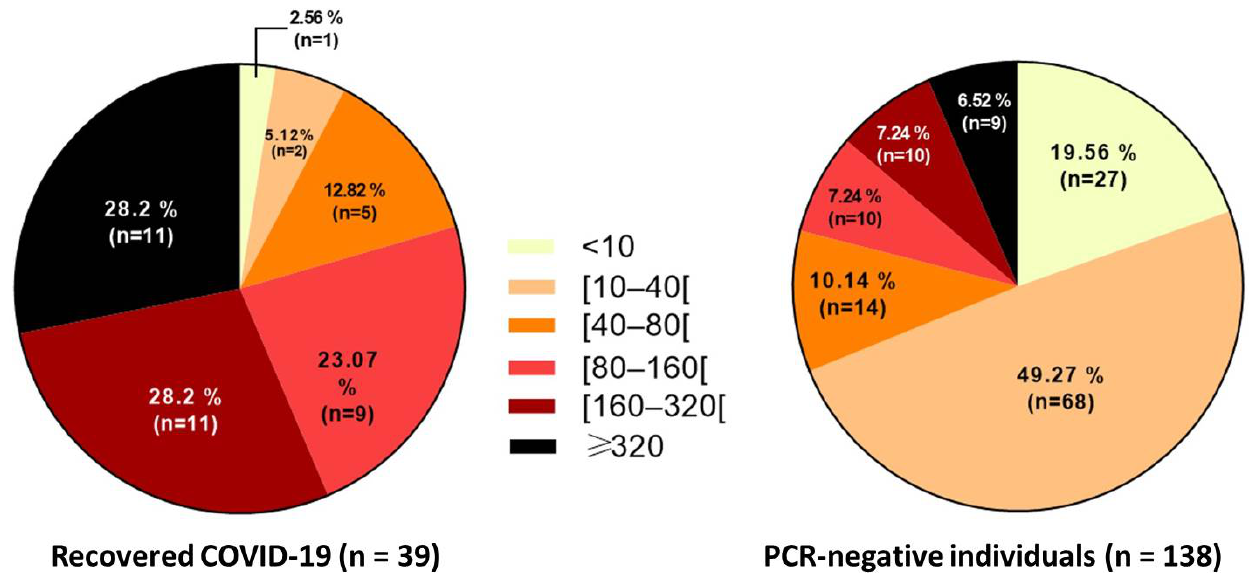
Figure 3. Distribution of neutralizing antibody titers among recovered COVID-19 patients ( left ) and PCR-negative individuals ( right ) after vaccination. The titer values are indicated by a gradient; lighter colors toward darker colors, to indicate the level of neutralizing activities between individuals.